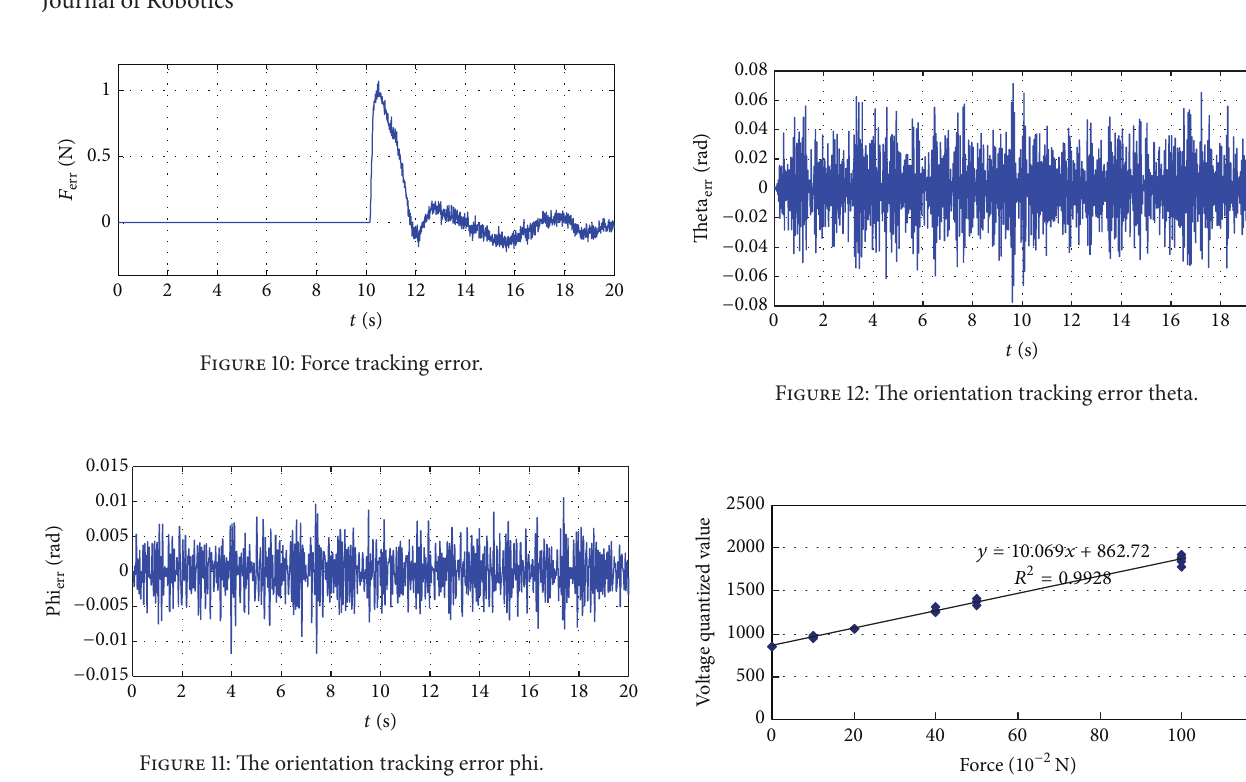
Figure 13: The mapping results between voltage and